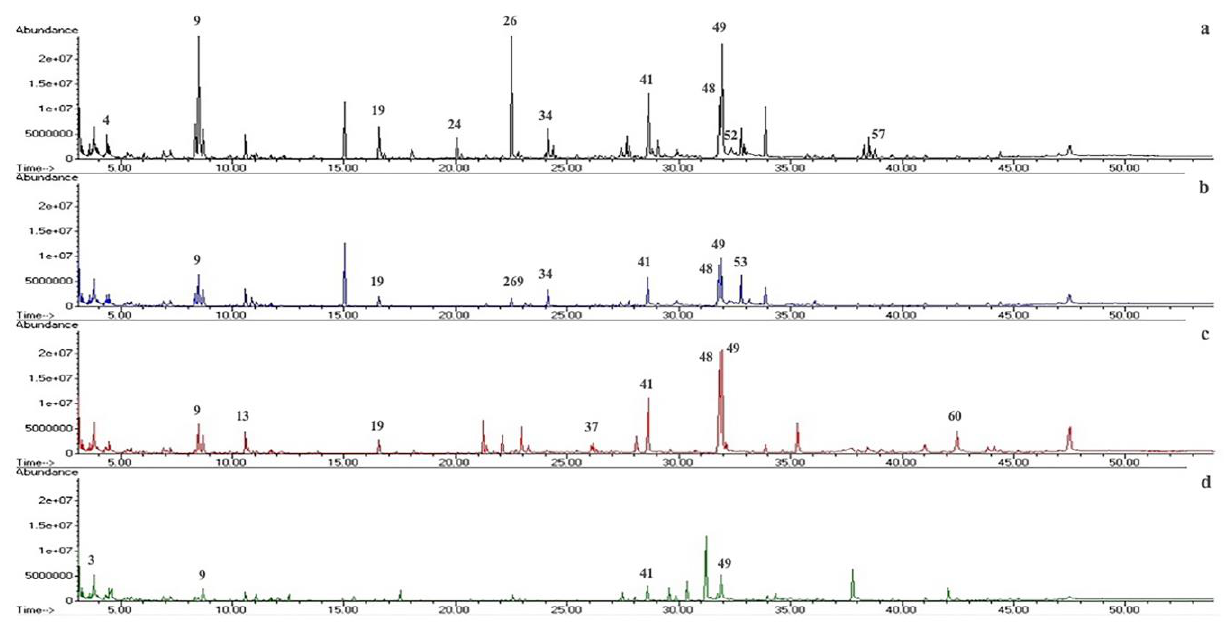
Figure 4. Representative chromatographic profiles of Trichoderma spp. ethyl acetate extracts ( a ) T. reesei (C2A), ( b ) T. sp. (C3A), ( c ) T. harzianum (C4A), and ( d ) T. spirale (C10). The major peaks have been numbered, and the corresponding compound names are given in Table 2.